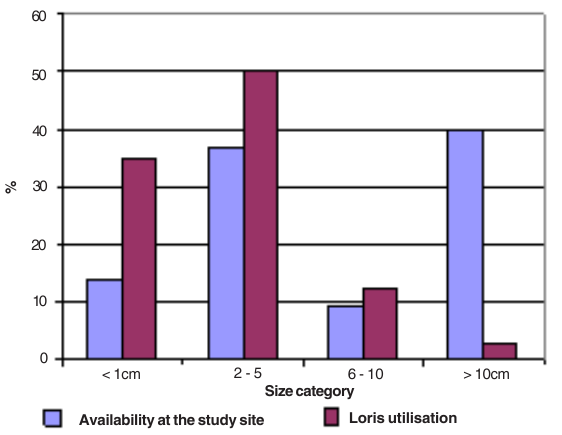
Figure 3. Percentage substrate size availability and usage by L.t.